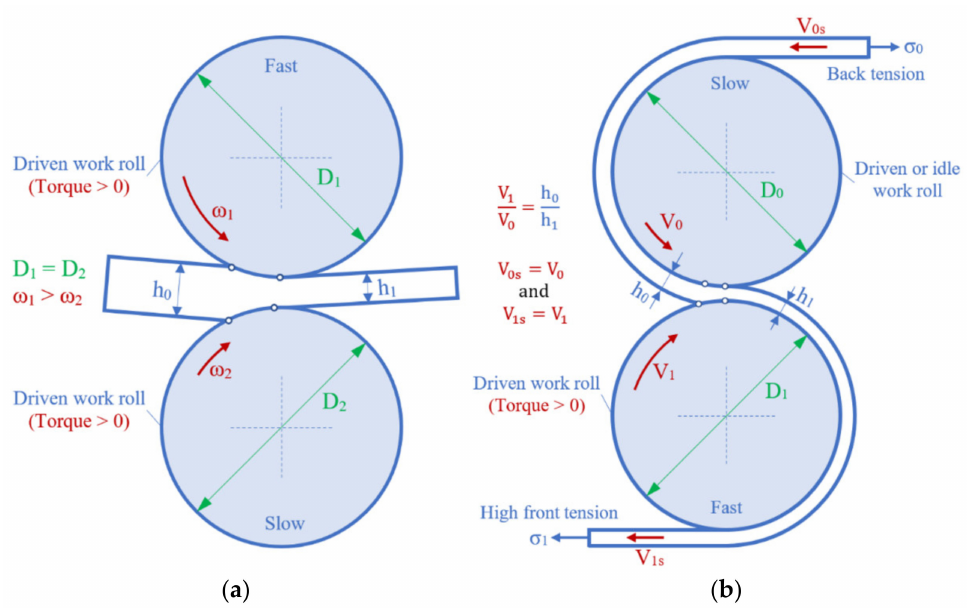
Figure 10. Schematic illustration of asymmetric rolling processes due to different circumferential speeds of the work rolls: ( a ) Rolling with different angular speeds of the work rolls; ( b ) “rolling– drawing”